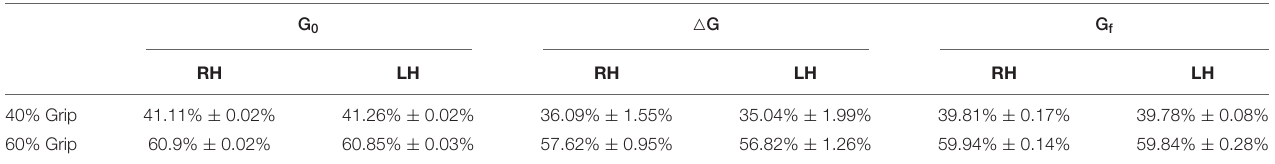
TABLE 3 | Average grip force (%MVC) computed in the three different phases of perturbations ( G 0 : during 200 ms before the onset of the perturbation; (cid:49) G : during the perturbation; G f : from the end of perturbation to 300 ms after the perturbation) in the 40 and 60% grip conditions.